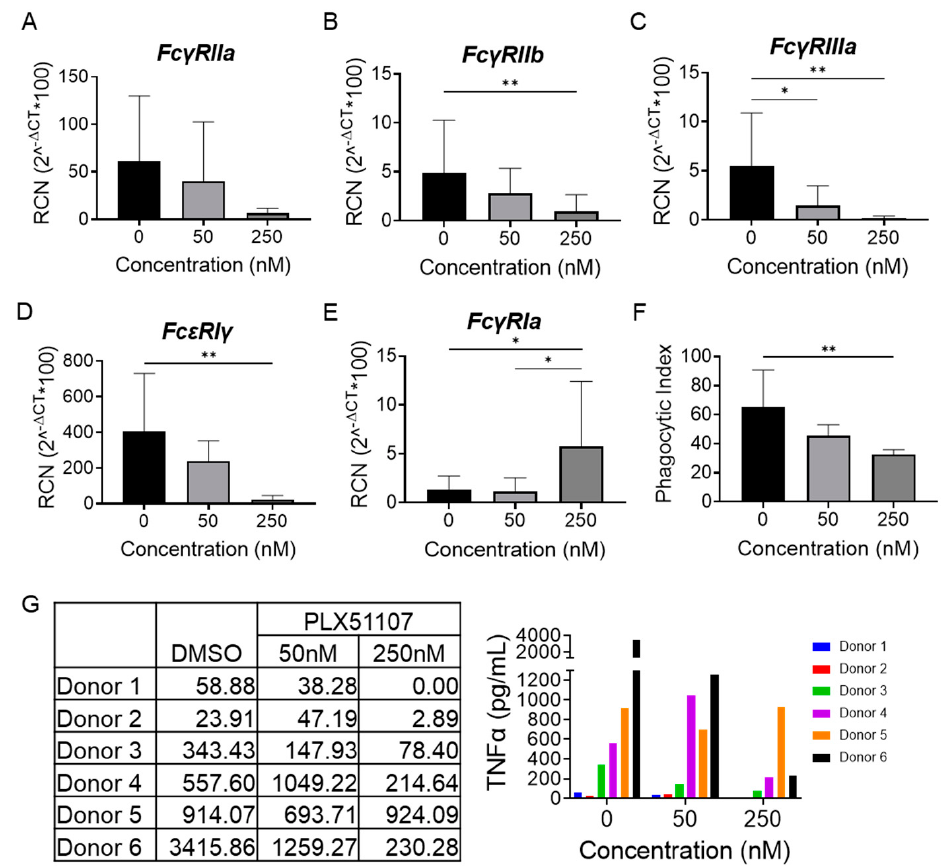
Figure 6. BET inhibition regulates Fc γ R expression and function in monocytes from rheumatoid arthritis patients. CD14 + monocytes from RA patients were treated with PLX51107 (50 nM, 250 nM) or vehicle control (DMSO) for 48 h and mRNA expression of ( A ) Fc γ RIIa, ( B ) Fc γ RIIb, ( C ) Fc γ IIIa, ( D ) Fc ε RI γ , and ( E ) Fc γ RIa, was analyzed by real-time PCR (n = 6). To analyze antibody-mediated functions, 24-h, PLX51107-treated RA patient CD14 + monocytes were ( F ) incubated at 37 °C with IgG opsonized sheep RBCs (SRBCs). Phagocytic index was measured using microscopy and defined as number of ingested RBCs per 100 monocytes (n = 4). ( G ) Similarly, PLX51107-treated RA patient CD14 + monocytes were stimulated with plate-bound IgG for another 24 h; supernatants were collected and TNF α levels were measured by ELISA; TNF α levels in control (DMSO) or PLX51107 conditions are shown for 6 different patients, represented as individual values (left) and a graph (right). * p ≤ 0.05, ** p ≤ 0.01